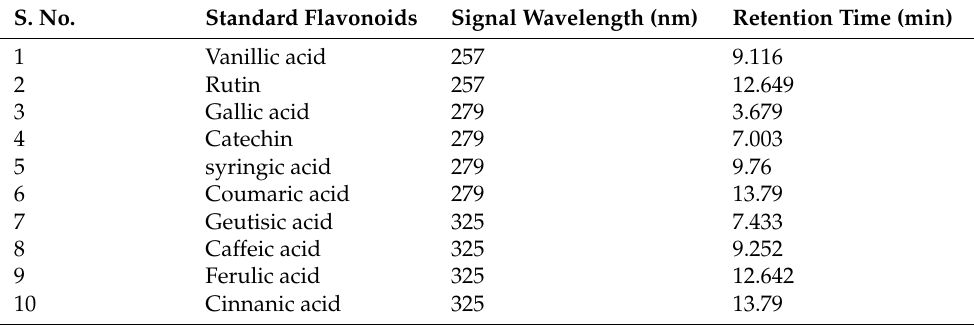
Table 1. Retention time of examined flavonoids with